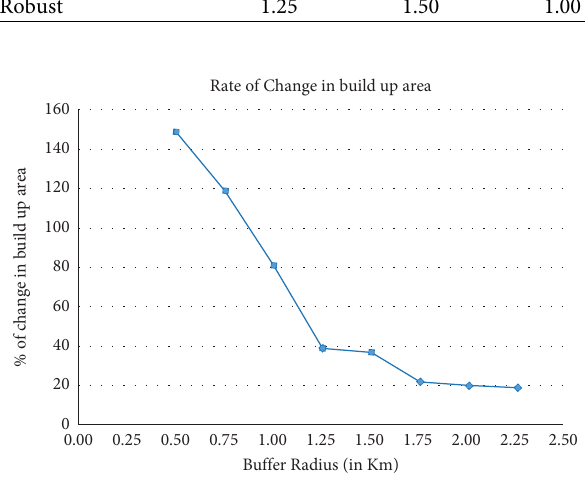
Figure 3: Rate of change in build-up area.